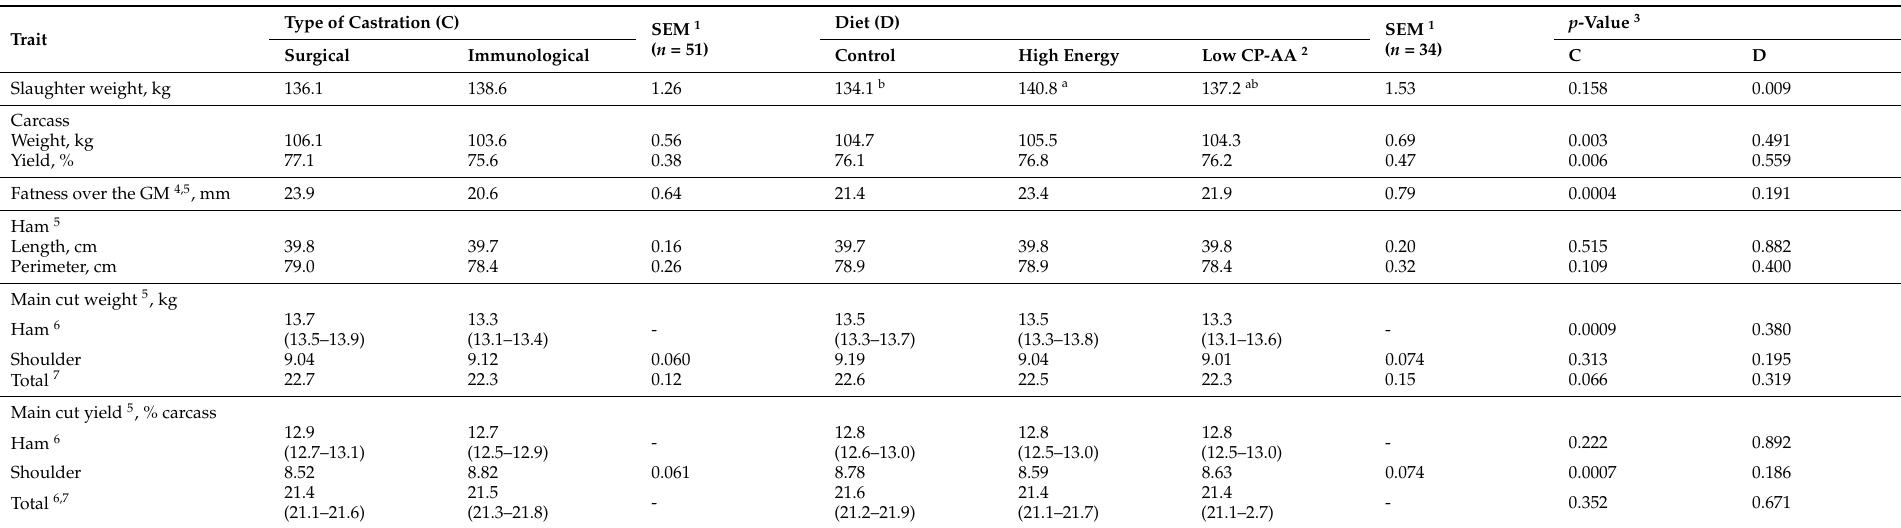
Table 5. Impact of type of castration and diet on carcass quality (least square means) of heavy male